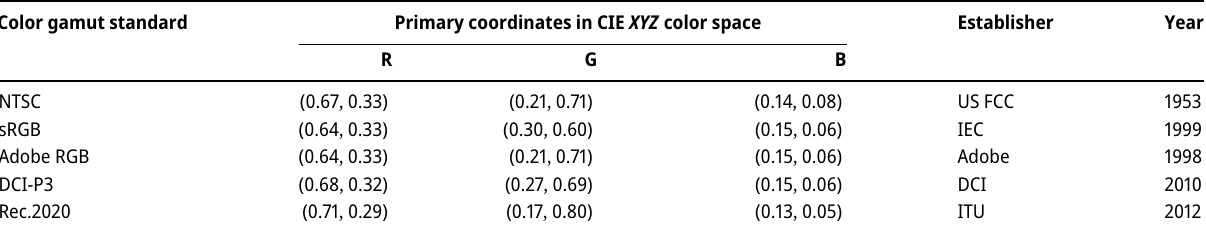
Table 1: Popular color gamut standards. Color gamut